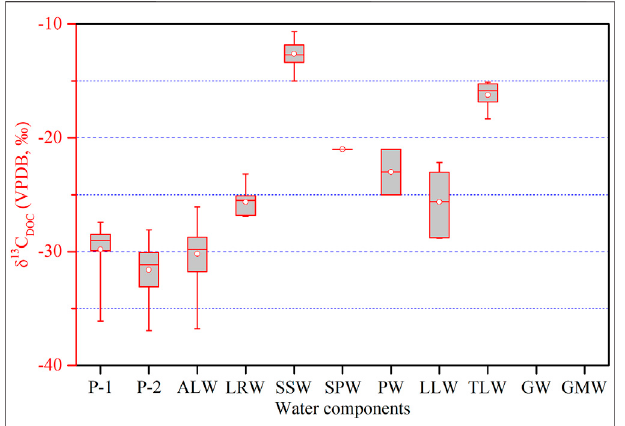
FIGURE 7 | Comparison of δ 13 C DOC in different water components on the QTP.